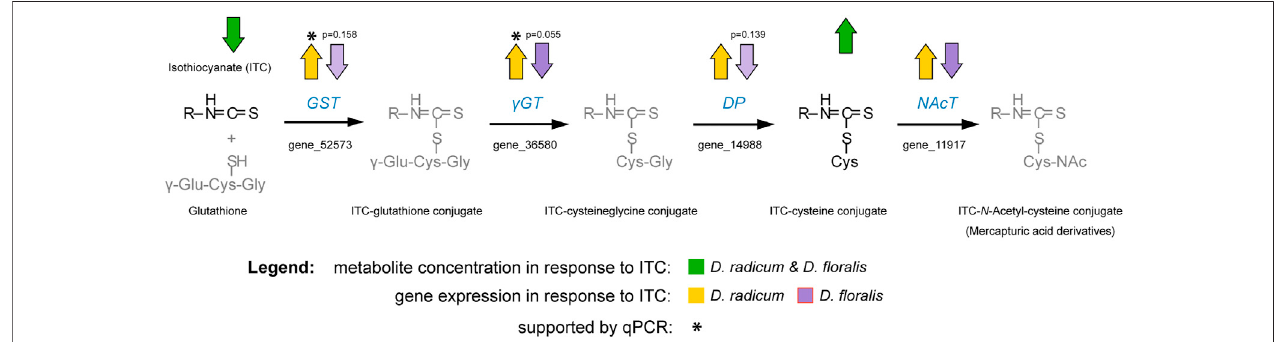
FIGURE 7| Schematic illustration of the observed detoxi fi cation ofisothiocyanates (ITCs) in the larvae of Delia radicum and D. fl oralis combined with the regulation ofgenesinthemercapturic acidconjugation pathway asassessed withtargeted metabolomicand transcriptomicdata.Arrows indicateanup- ordownregulationwitha p -value < 0.05 unless otherwise noted in the fi gure. Pathway was modi fi ed after Higdon et al. (2007). Abbreviations: GST, glutathione- S -transferase; γ GT, gamma- glutamyltransferase; DP, dipeptidase; NAcT, N -acetyltransferase.